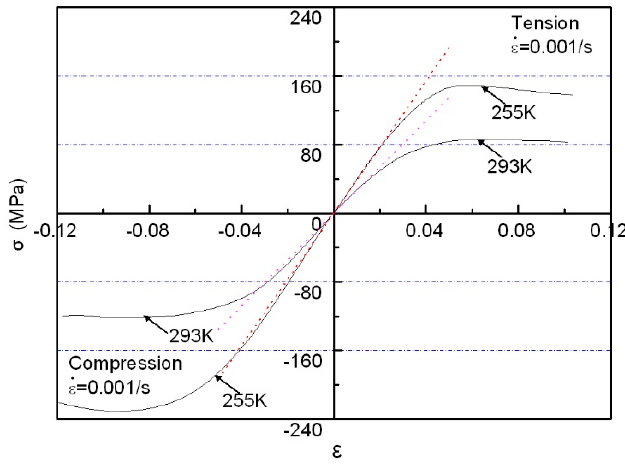
Figure 16. Comparison of quasi-static tensile and compressive curves at two different temperatures.